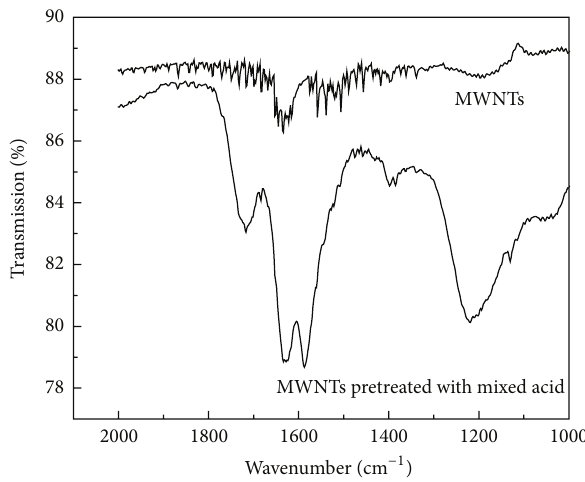
Figure 2: FTIR pattern of MWNTs and MWNTs pretreated with mixed